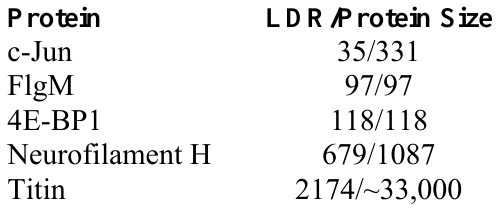
TABLE 1. Representative samples from our database of over 90 nonhomologous proteins that contain long disordered regions (LDRs) of ≥ 30 contiguous amino acids. "LDR/Protein Size" represents the length of the disordered region and the protein respectively. "Function" refers to the function of the disordered region.